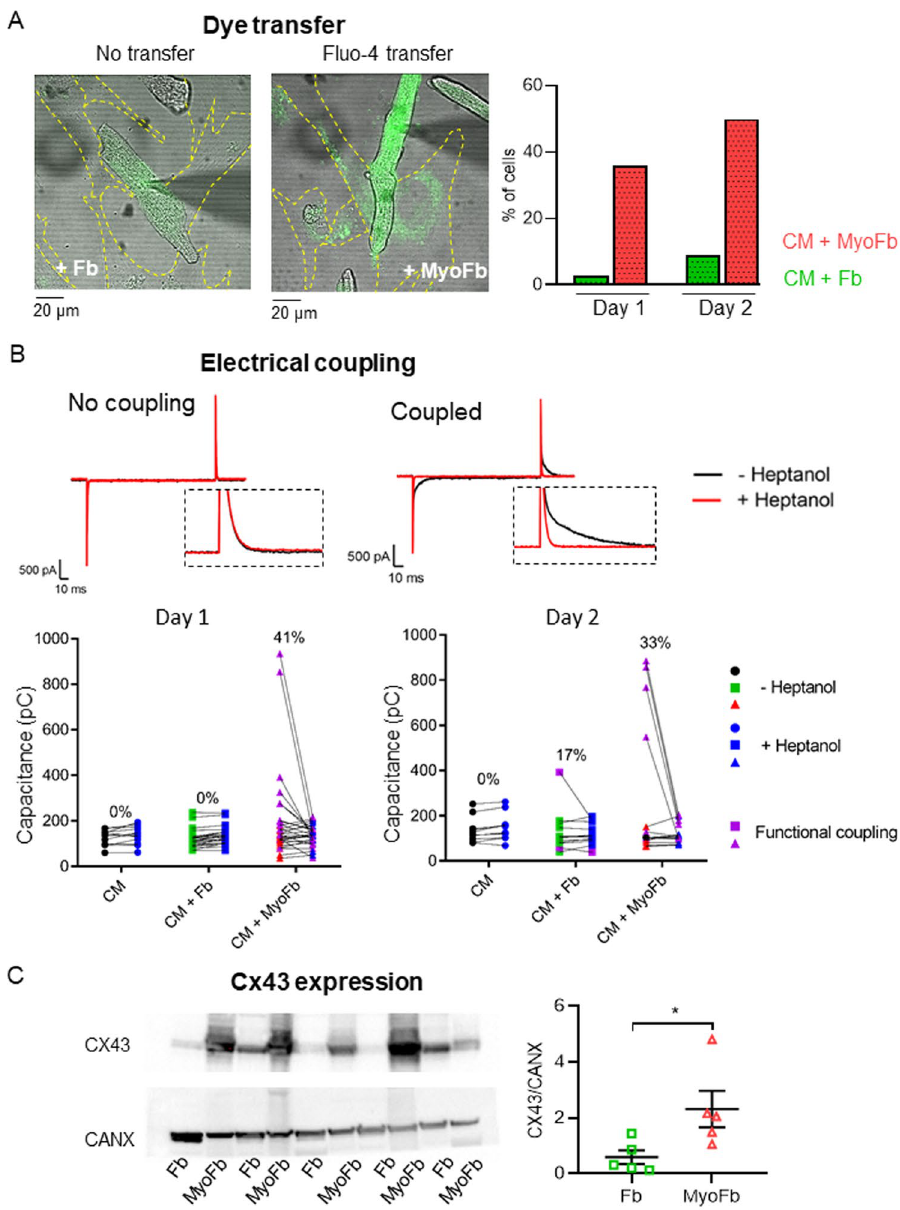
Figure 5. Identification of functional coupling of CM with (Myo)Fbs in direct co-culture. ( A ) Example of studying dye transfer (Fluo-4) between CM and Fb (no transfer) or MyoFb (transfer) and mean data at day 1 and day 2 in direct co-culture (n cells = 11–31; N culture = 3–5). ( B ) Examples and mean data of cell membrane capacitance measurement of CMs before and after heptanol application. Changes in cell capacitance larger than 10 pF are shown in purple and indicate functional couplings between CMs and Fb phenotype (n cells = 10–30; N culture = 3–5). ( C ) Connexin 43 protein blot and expression in cell lysates. (N = 5; two-tailed Student t-test, * p =